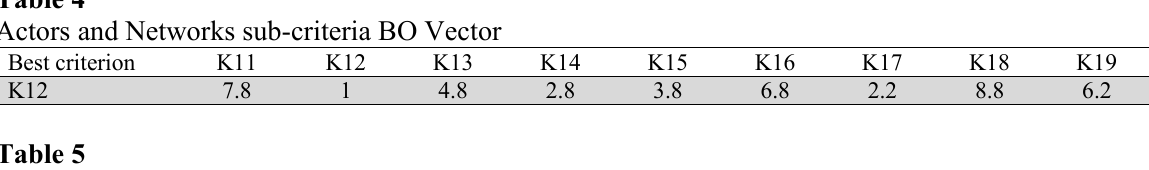
Institutions sub-criteria BO Vector Best criterion